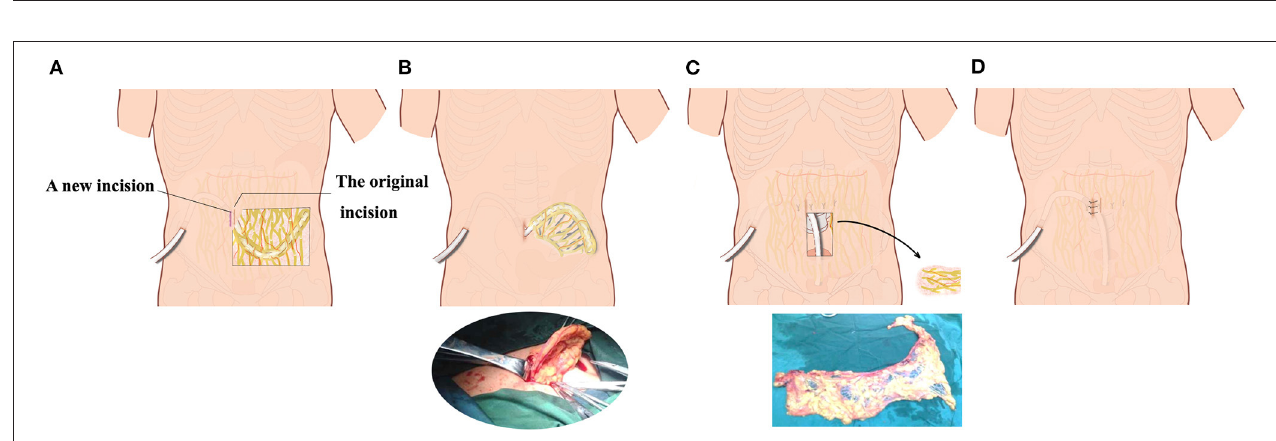
FIGURE 1 | Schematic diagram of surgical technique of PD placement. (A) Location of the incision. (B) The skin was incised and separated layer by layer to the posterior sheath of the rectus abdominis. (C) The posterior sheath was then cut and a purse suture was made. (D) Insertion of the catheter and ligating the pox. The internal cuff was secured within the rectus muscle. (E) A subcutaneous tunnel was established and the incision was closed.